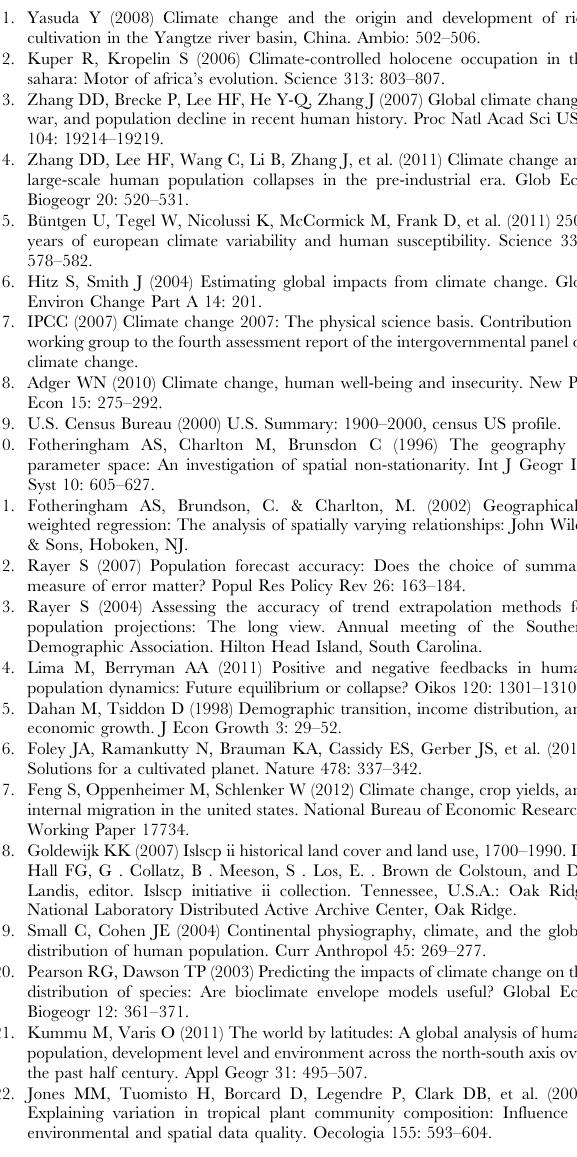
one across all temporal horizons. The non-stationary nature of GWR was taken into account by adjusting the number of